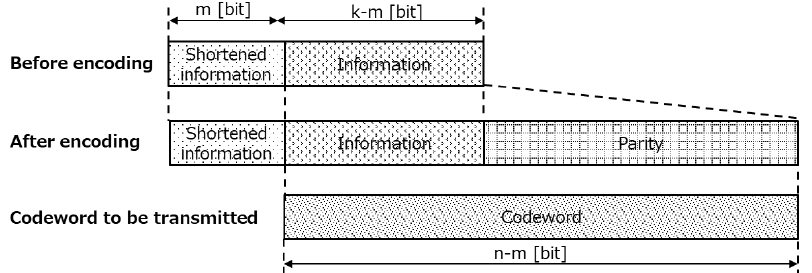
Figure 2. Encoding procedure of ( 𝑛 − 𝑚 , 𝑘 − 𝑚 ) shortened code.